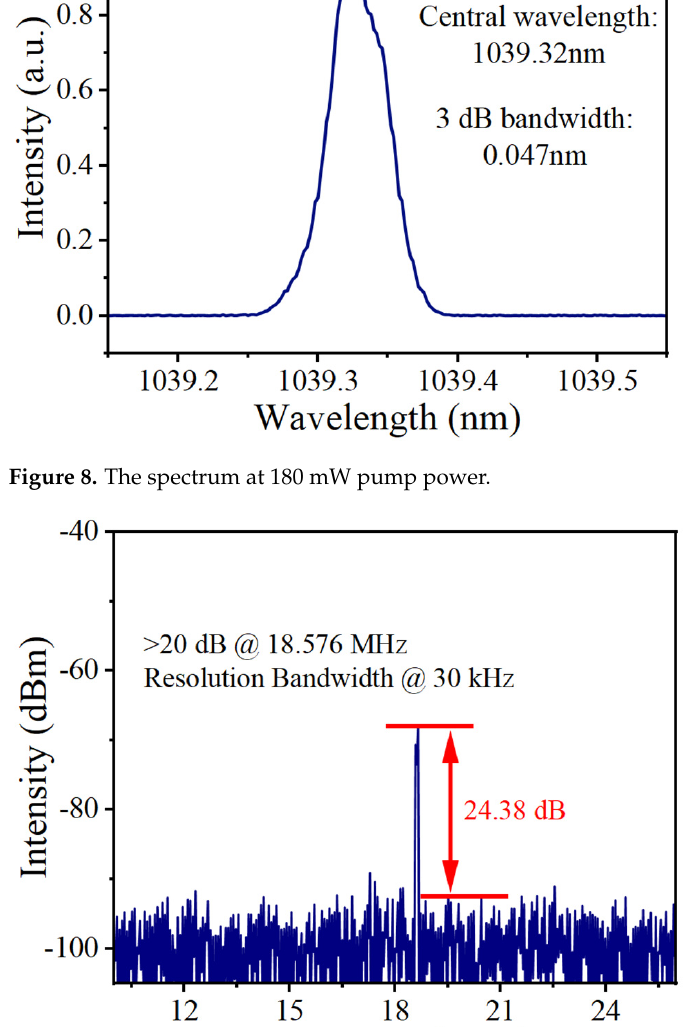
Figure 10. Average output power and single pulse energy with pump power. In the figure, the CW is in continuous wave, and ML is mode-locked. In recent years, FONPs have been continuously adopted in YDFLs to achieve Q- switched and mode-locked operations. In Table 1, we can observe that Fe 3 O 4 nanosheets exhibit some advantages in pulse duration and modulation depth, compared to FONPs.